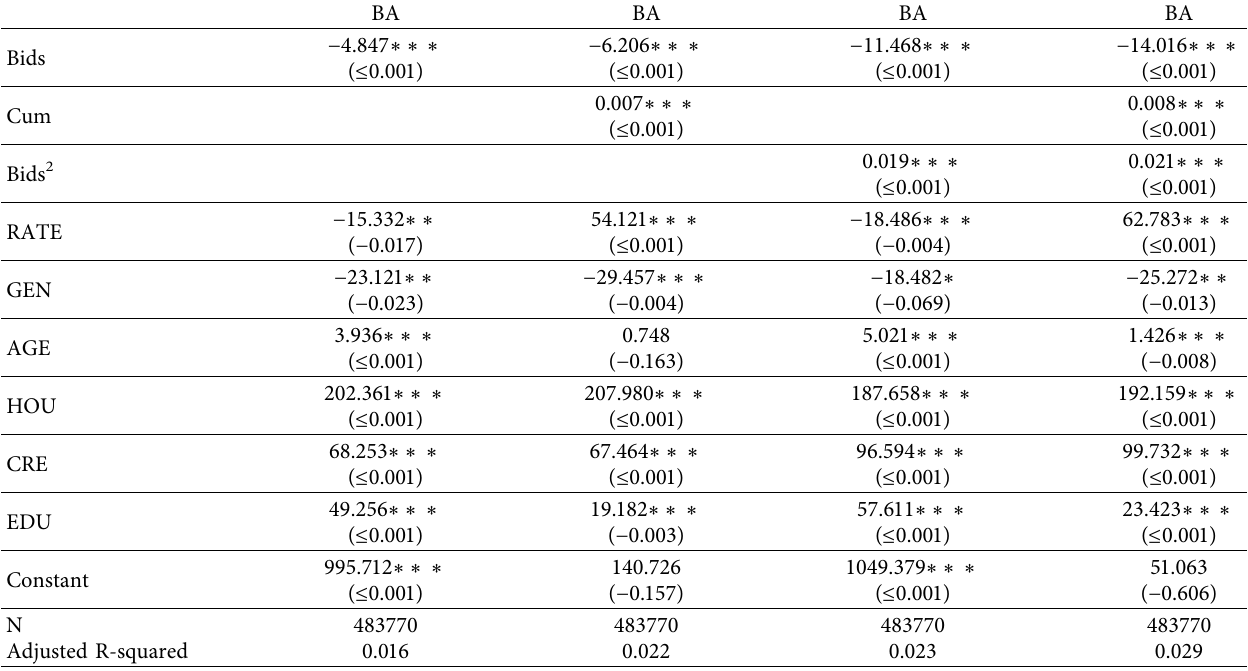
Table 10: Using alternative dependent variable and independent